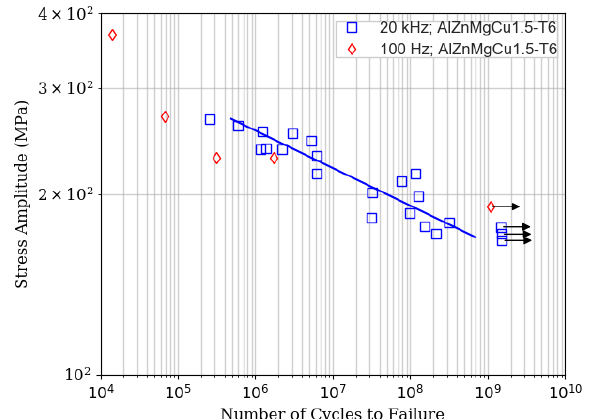
Figure 15: Fatigue test results of ultrasonic tests (20KHz, R=-1) and rotary bending tests (52.5Hz, R=-1) on wrought IN718 [26].